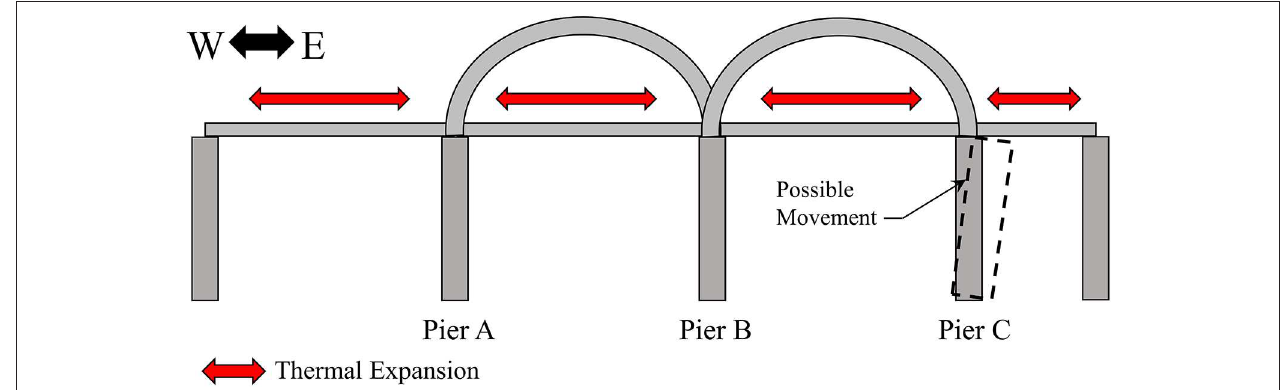
FIGURE 10 | Illustration of the Pier C substructure movement.